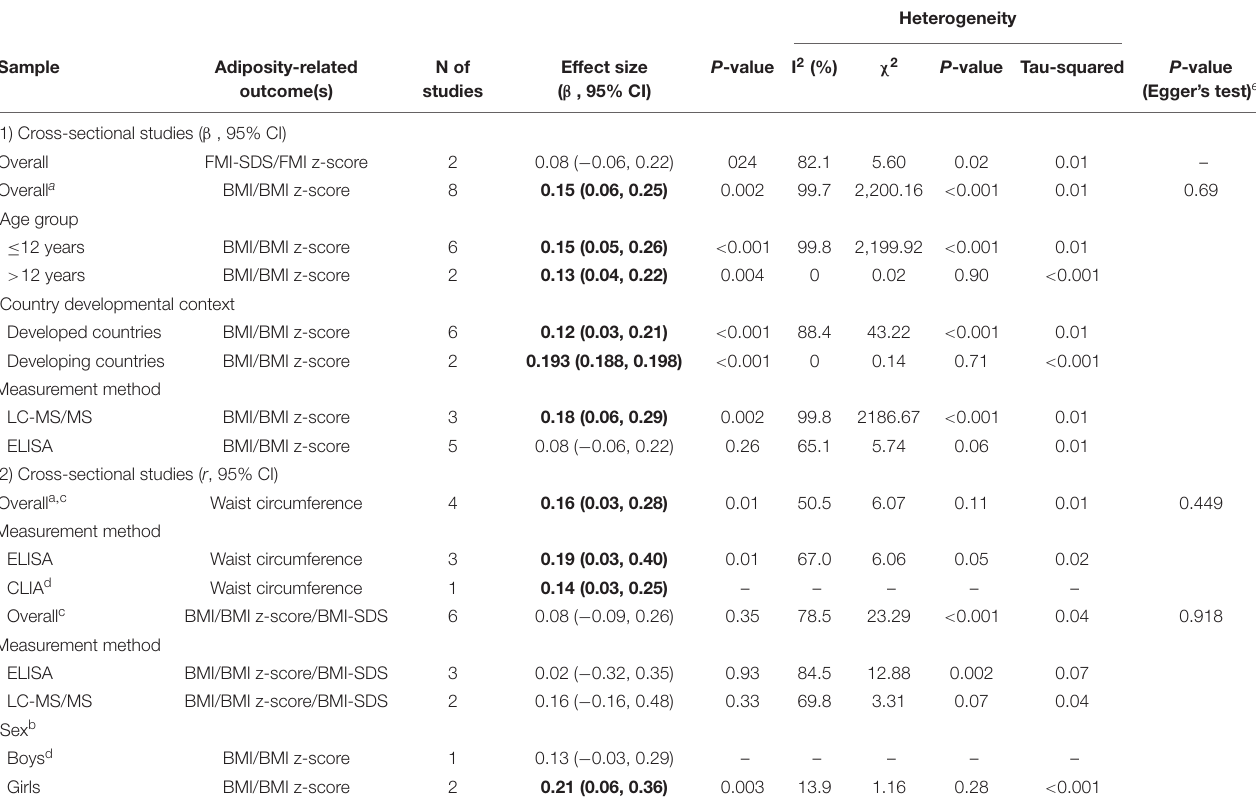
TABLE 2 | Overall and sub-group meta-analysis of the associations between hair cortisol concentration and adiposity-related outcome(s) among children based on 20 included studies.